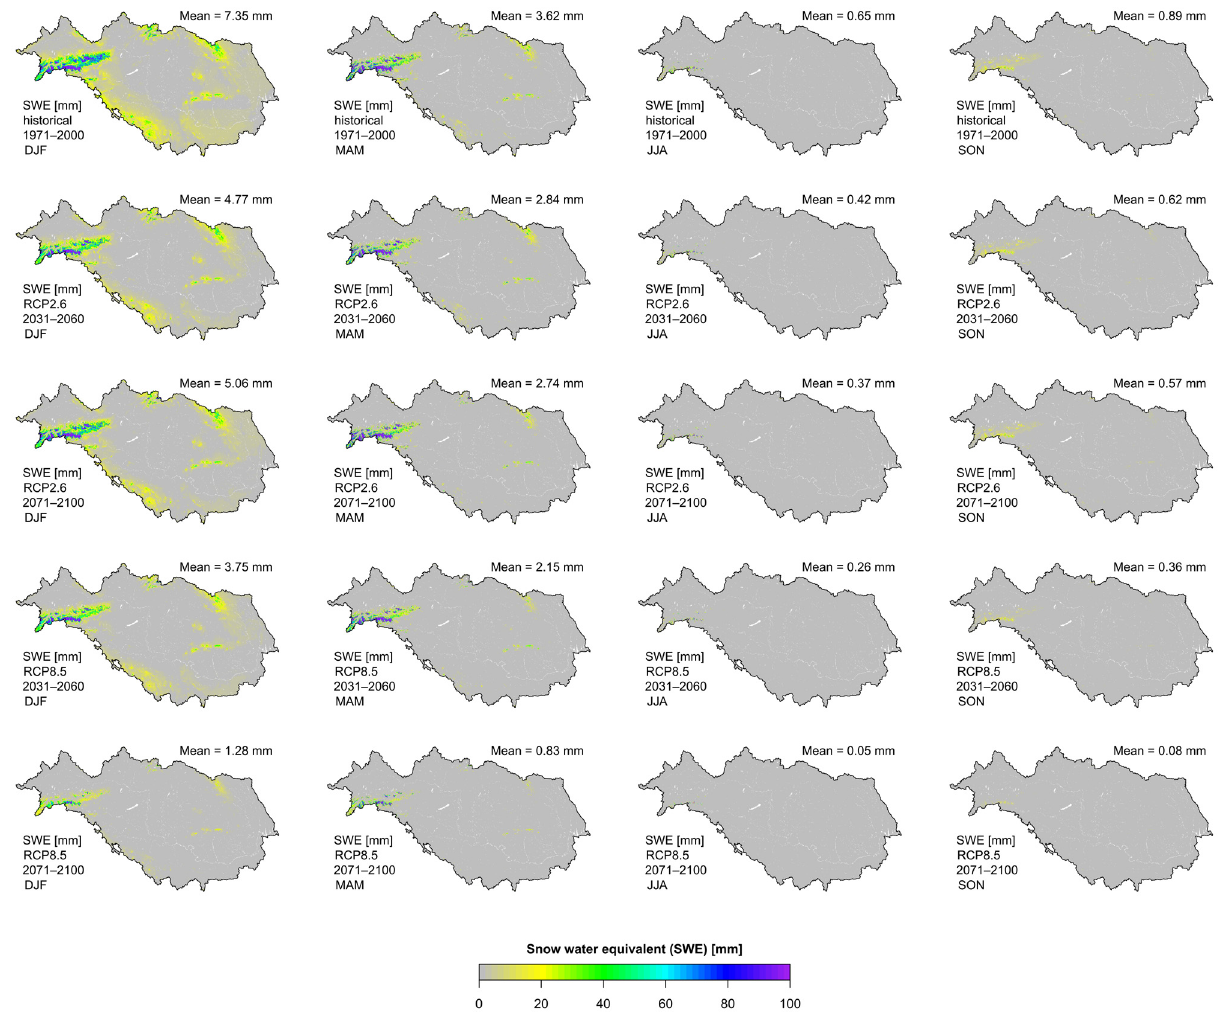
Figure 11. Maps of the long-term mean seasonal snow water equivalent (SWE) [mm] for the historical GCM-RCM-driven simulations (ensemble mean, 1971–2000) as well as for the GCM-RCM-driven simulations (ensemble mean) under RCP2.6 and RCP8.5 for the near future (2031–2060) and the far future (2071–2100) in the Danube River Basin.